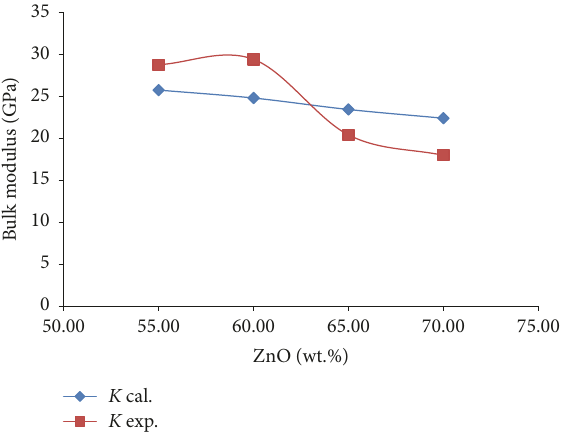
Figure 12: Experimental and theoretical longitudinal modulus versus wt.% of ZnO in ZnO–SiO 2 samples.